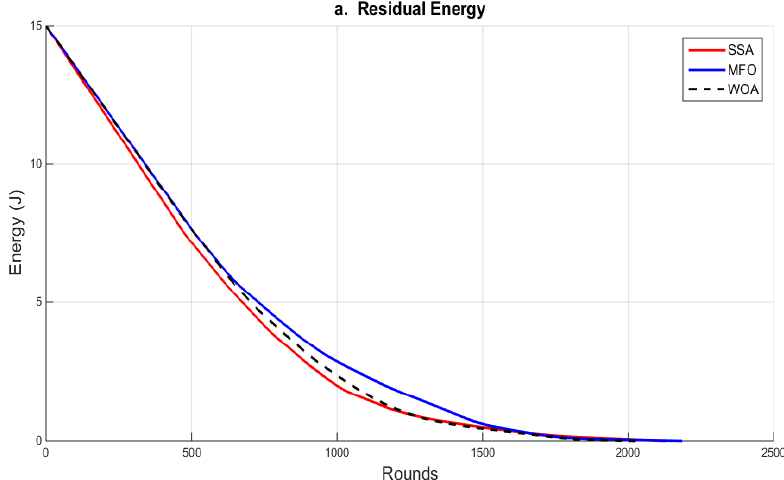
Figure 5. The number of rounds versus residual energy within WOA, MFO and SSA.